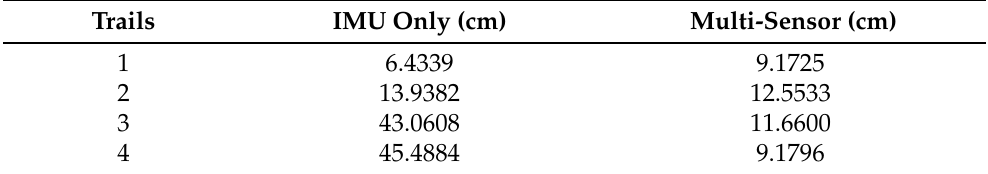
Table 2. Drift error for IMU-only and proposed multi-sensor system against ground truth position.